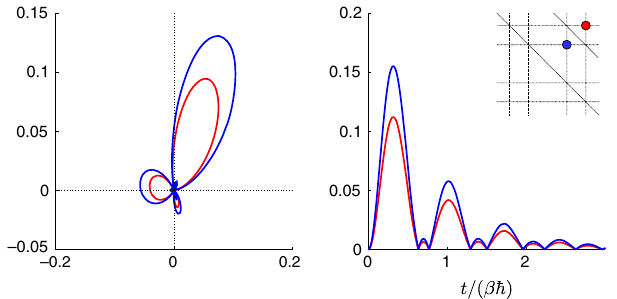
FIG. 18. Off-diagonal fluctuation relation in the case of no decoupling. The fluctuation theorem (M18) relates the evolution of the coherences carried by two off-diagonal elements along two different displaced diagonals. Hence, as opposed to the case in Fig. 10, the two off-diagonal elements belong to two different modes of coherence. For the setting in Fig. 10, the quantities d (cid:4) defined in Eq. (M18) would be identically zero, while for the new measurement operators (M19), they become nontrivial and satisfy the fluctuation relation in Eq. (M18). The plot on the right displays j d j (red curve) and j d − j (blue curve), while the left plot þ depicts the trajectories d (red curve) and d − (blue curve) in the þ complex plane. Like in Fig. 10, the proportionality of the absolute values and identical phase factors predicted by Eq. (M18) are